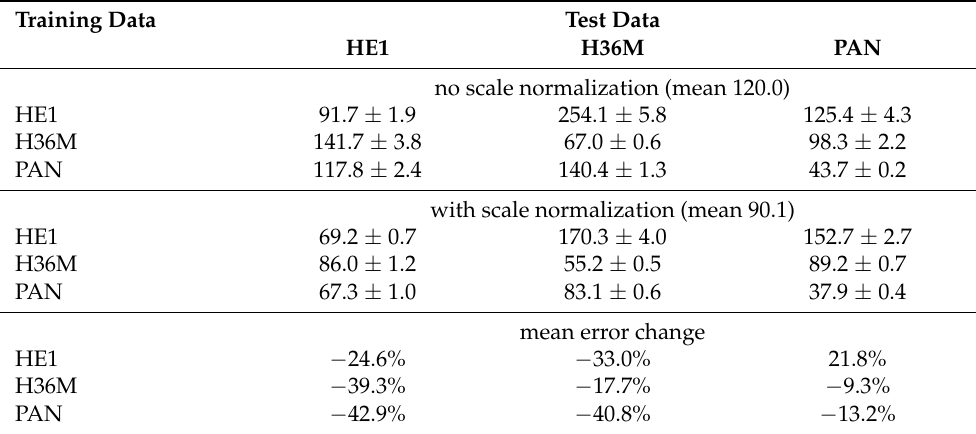
Table 9. Error with and without scale normalization (no-alignment errors in mm, mean ± std.